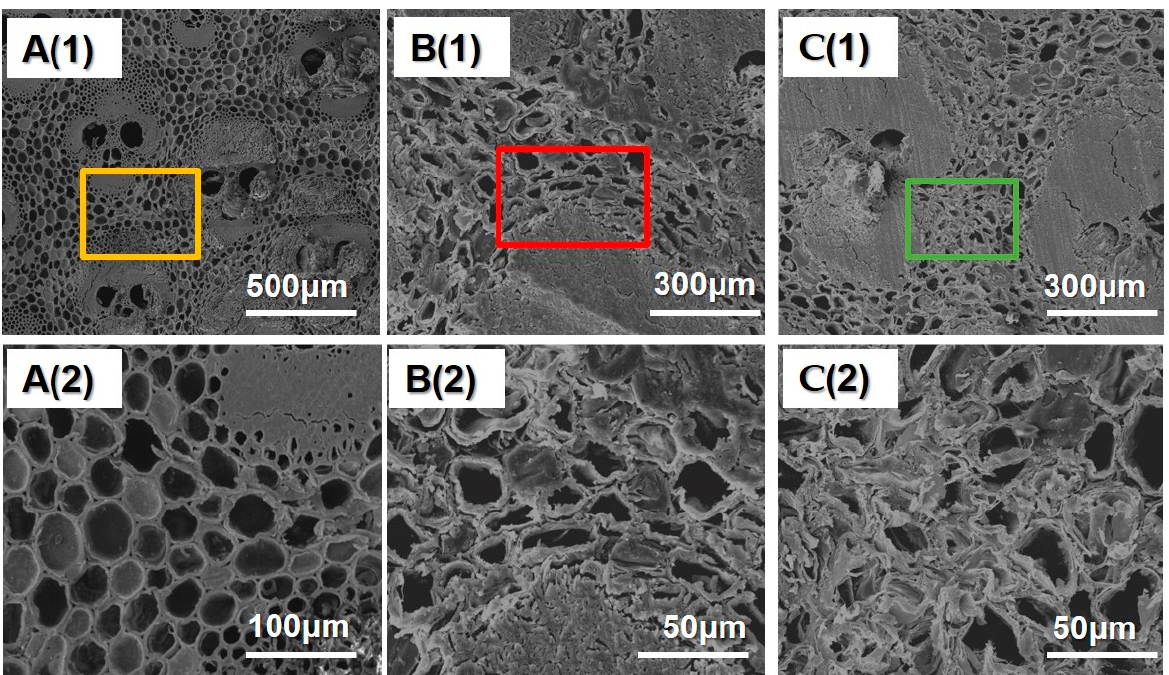
Figure 3. SEM images of cross-section of different bamboo specimens. ( A ) (1–2) control. ( B ) (1–2) 160 ◦ C/90 min; ( C ) (1–2) 180 ◦ C/90 min. Table 1. Relative content of chemical composition in bamboo